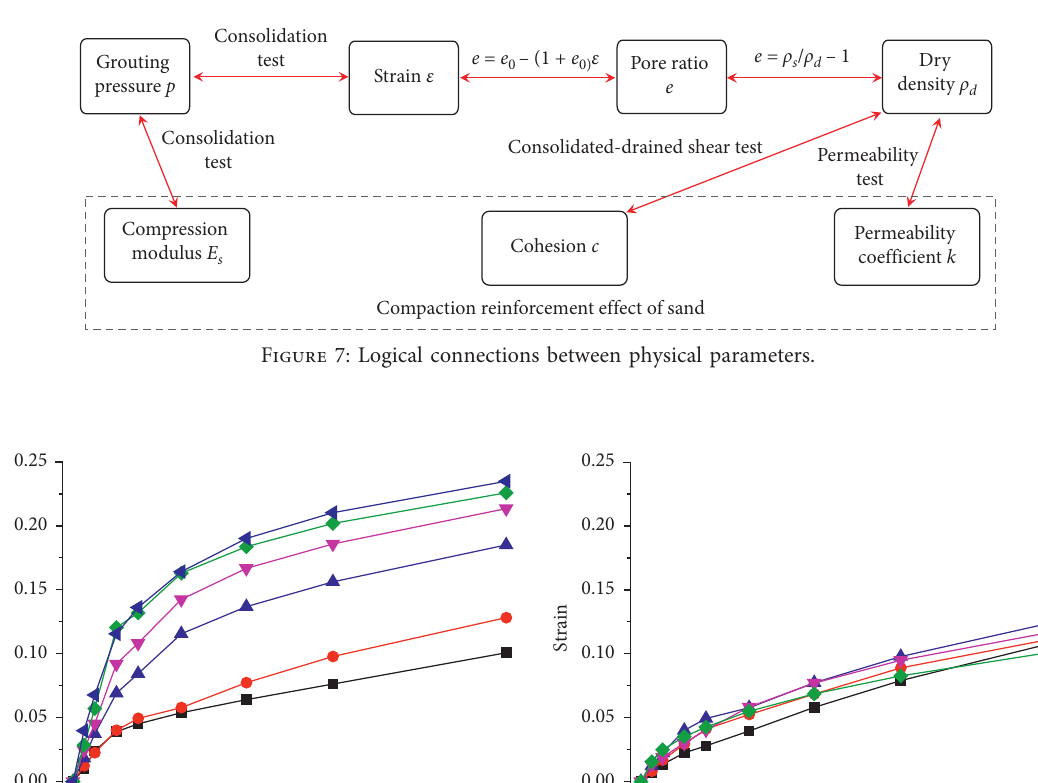
r during the compaction process.